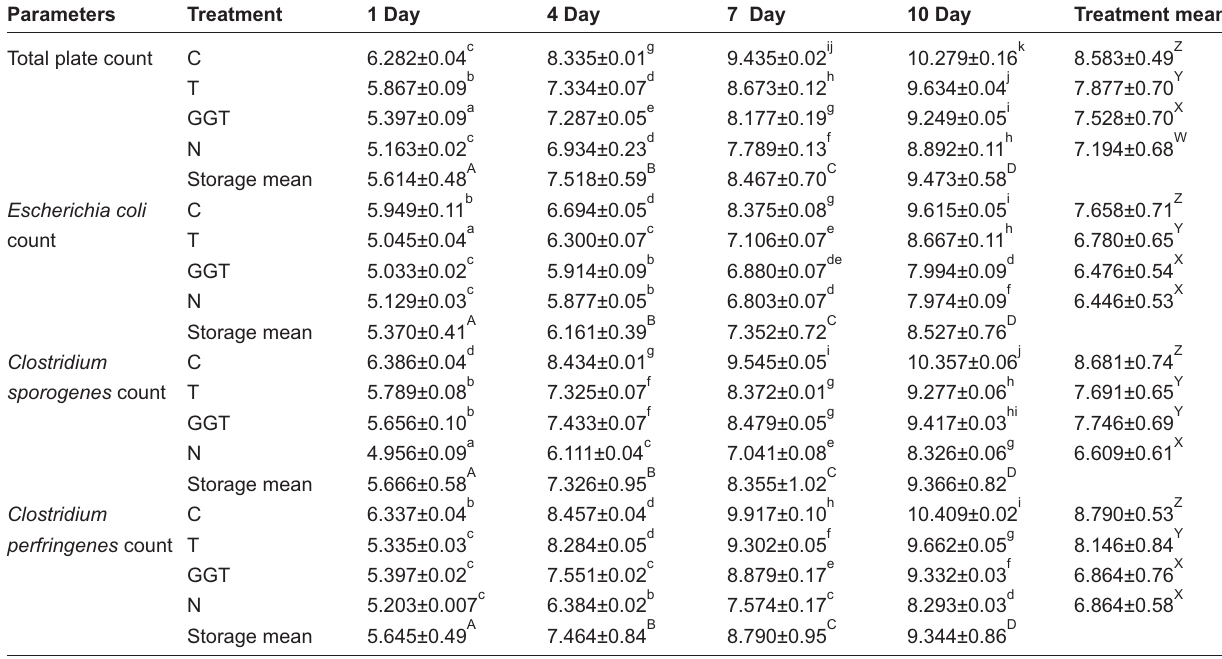
Table :-2 Mean±S.E. values of various microbiological properties for different treatments and storage period Parameters